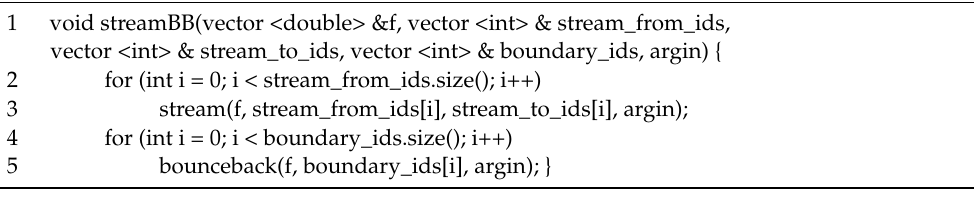
Algorithm 5. Non-local operation with indirect addressing.